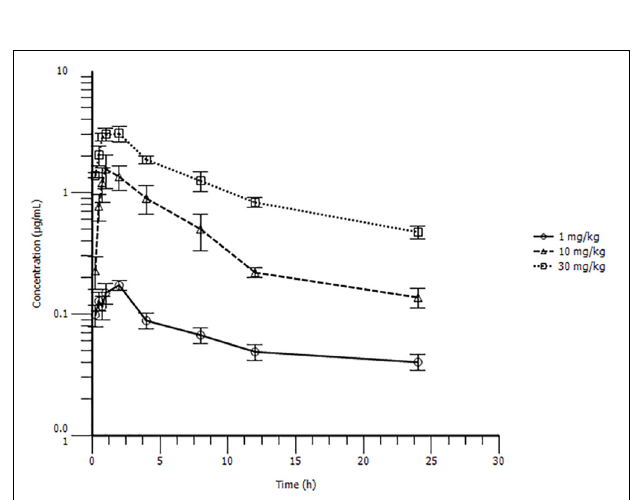
FIGURE 3 | Serum drug concentration-time profile of danofloxacin after oral administration at 1, 10, or 30 mg/kg body weight (b.w.) in S. typhimurium infected rabbits ( n = 10/time